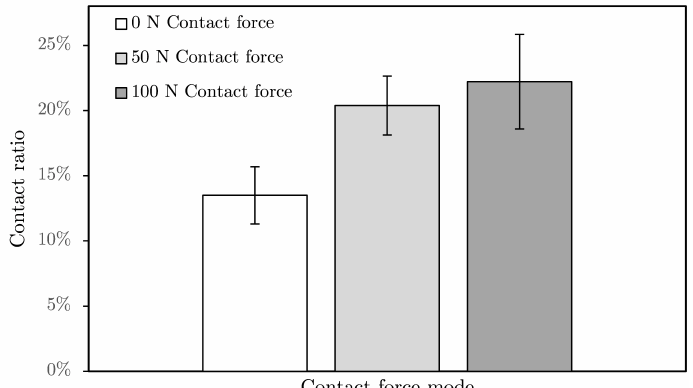
Figure 15. Contact ratio of the sintered joint as a function of the initial contact force.